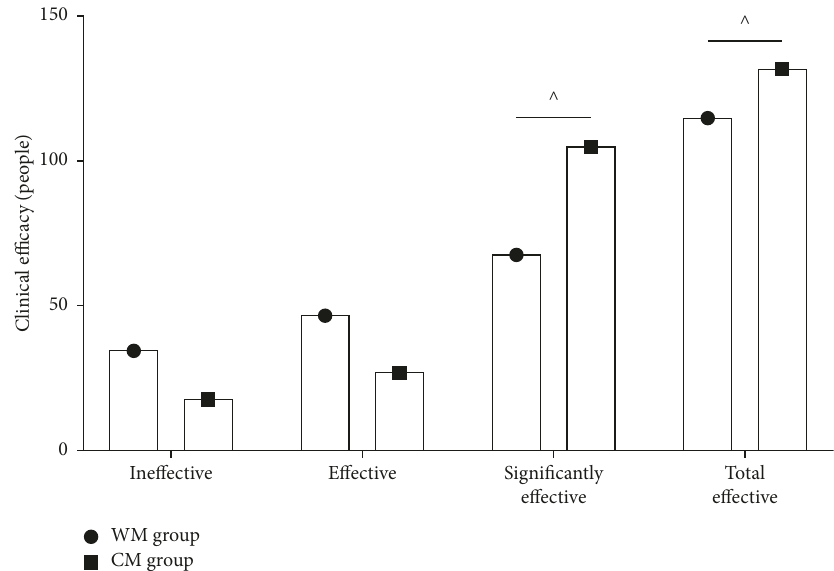
Figure 6: Comparison of clinical efficacy in two groups. Comparison between groups,